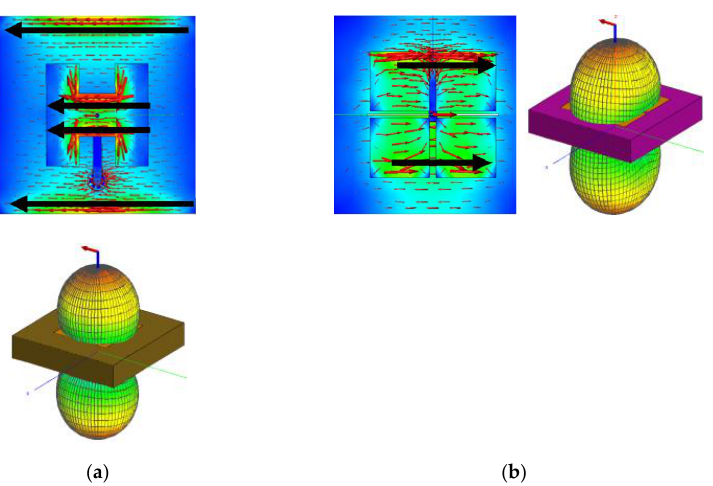
antenna B, and ∆ϕ 6 is the phase difference between mode 2 of antenna A and antenna B. There, ∆ϕ 6 is 175° at 6.0 GHz and the corresponding values of 𝐴 𝑛 are about 0.015. Therefore, a cancellation effect of antenna A and antenna B is produced outside of operating band. It can be concluded that the RCSR of an array antenna composed of antenna A and antenna B can be obtained from 4.2 GHz to 6.6 GHz for the x -polarized incident wave. ( a )